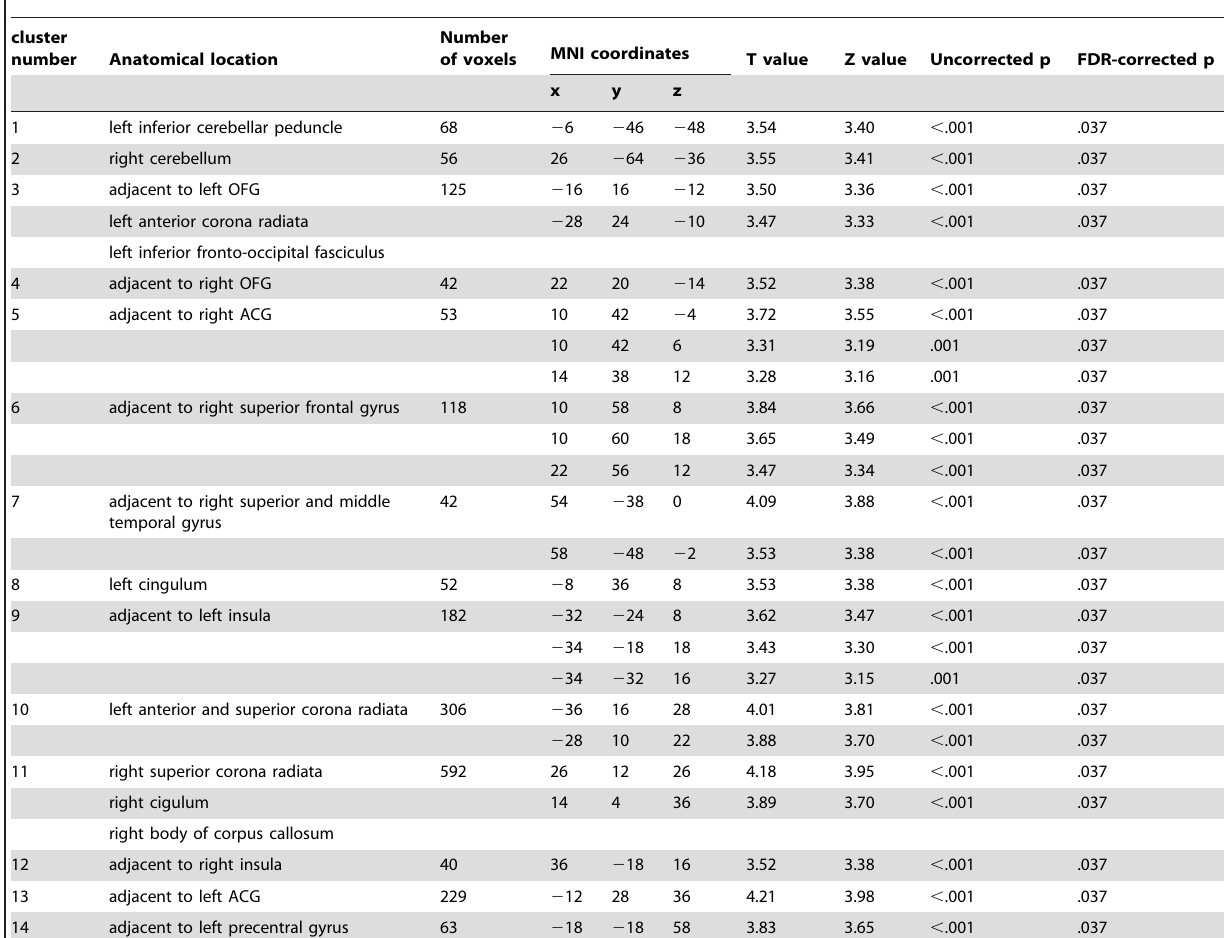
Table 2. White matter volume reductions in the patients with panic disorder compared with the healthy control subjects.